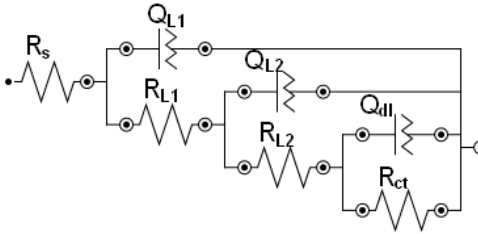
Figure 13. Equivalent circuit used for the modeling of the electrical impedance spectroscopy (EIS) spectra of sintered iron samples with and without PEG coating before degradation and after immersion in Hanks’ solution for 24 and 48 h. R s is the solution resistance, R L 1 is the pore resistance, R L2 is the resistance of polymer layer or the corrosion products, and R ct is the charge transfer resistance. Q L 1 , Q L 2 , and Q dl are the constant phase elements. Table 6. Impedance parameters of uncoated and PEG-coated open cell Fe samples at f max = 0.01 Hz. Impedance Parameter Unit Time of